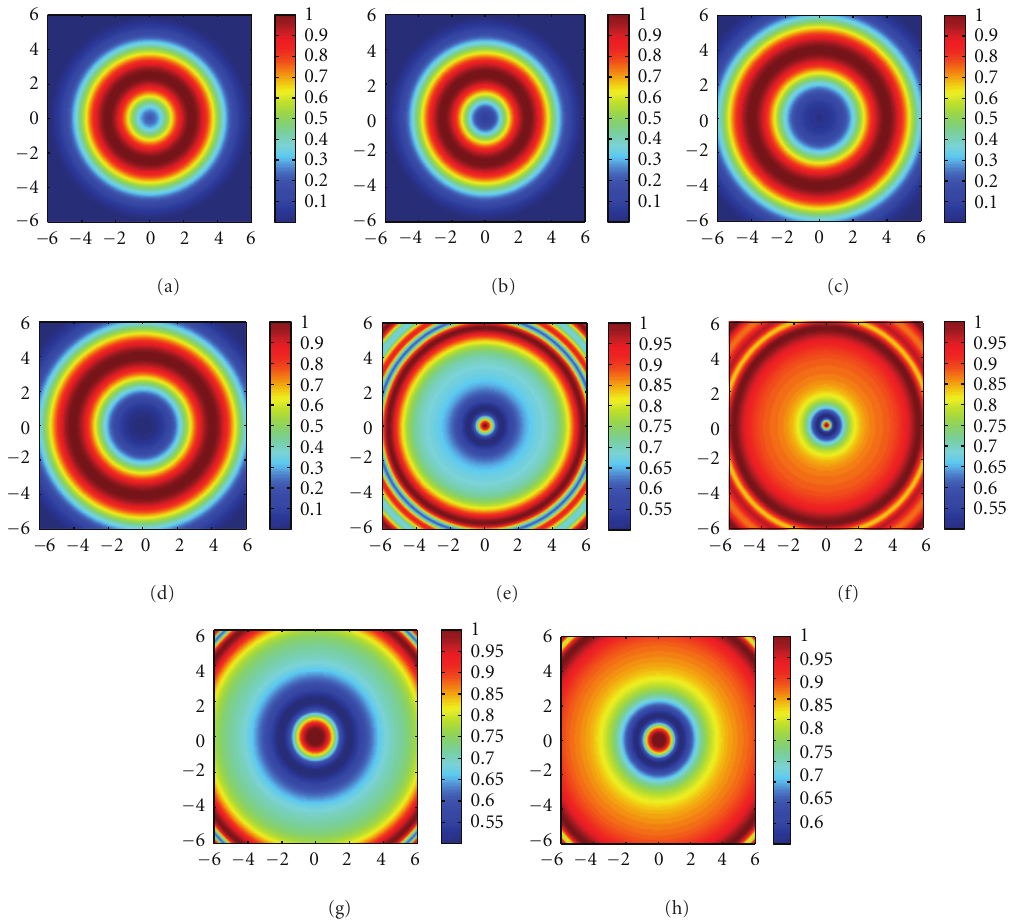
Figure 2: Intensity distribution of uniformly polarized vortex beams at the focal plane of an air aplantic lens with NA = 0 . 9: with m = 1 and β = π/ 2 for (a) μ o = 0 . 5 (b) μ o = 0 . 8; for m = 2 and β = π/ 2 with (c) μ o = 0 . 5 (d) μ o = 0 . 8; degree of polarization for m = 1 and . 5 (f) μ . 8; for m = 2 and β = π/ 2 with (g) μ β = π/ 2 for (e) μ o = 0 o = 0